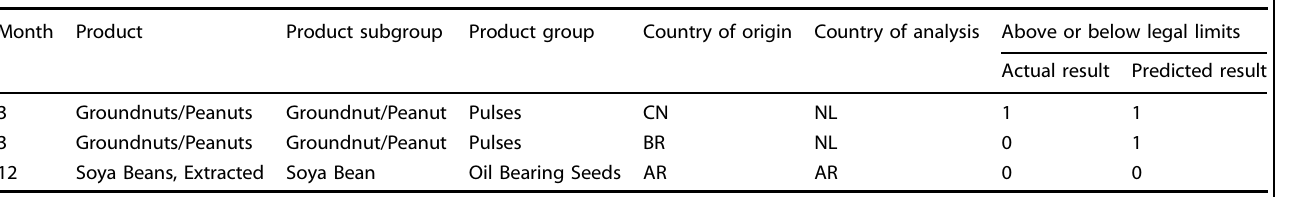
Table 1. Examples of ML model validation results.